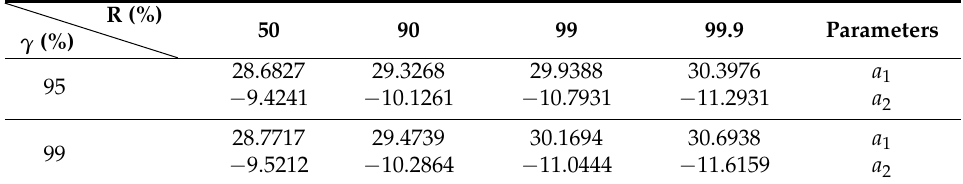
Table 6. Parameters of P-S-N curves with R a = 1.6 μ m.